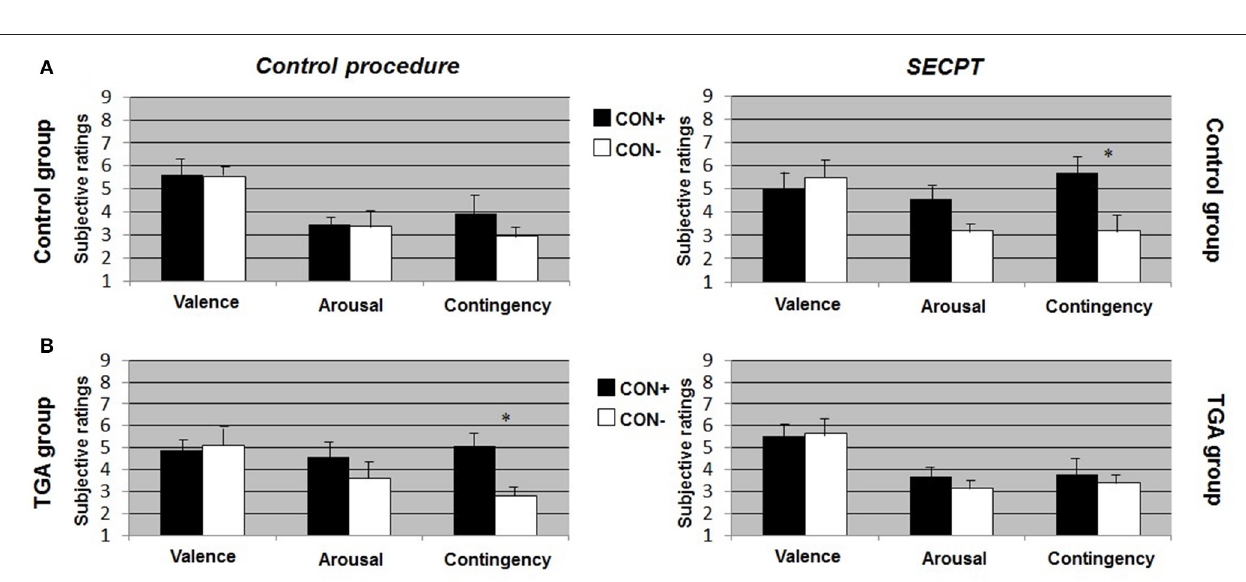
FIGURE 2 | Subjective ratings of valence, arousal and contingency during the acquisition phase of the contextual fear conditioning paradigm. (A) In the control group, (B) in the TGA group, following the control procedure and the SECPT. * p < 0.05. CON + , conditioned stimulus paired with the unconditioned stimulus; CON − , conditioned stimulus never paired with the unconditioned stimulus; SECPT, Socially Evaluated Cold Pressor Test; TGA, transient global amnesia.